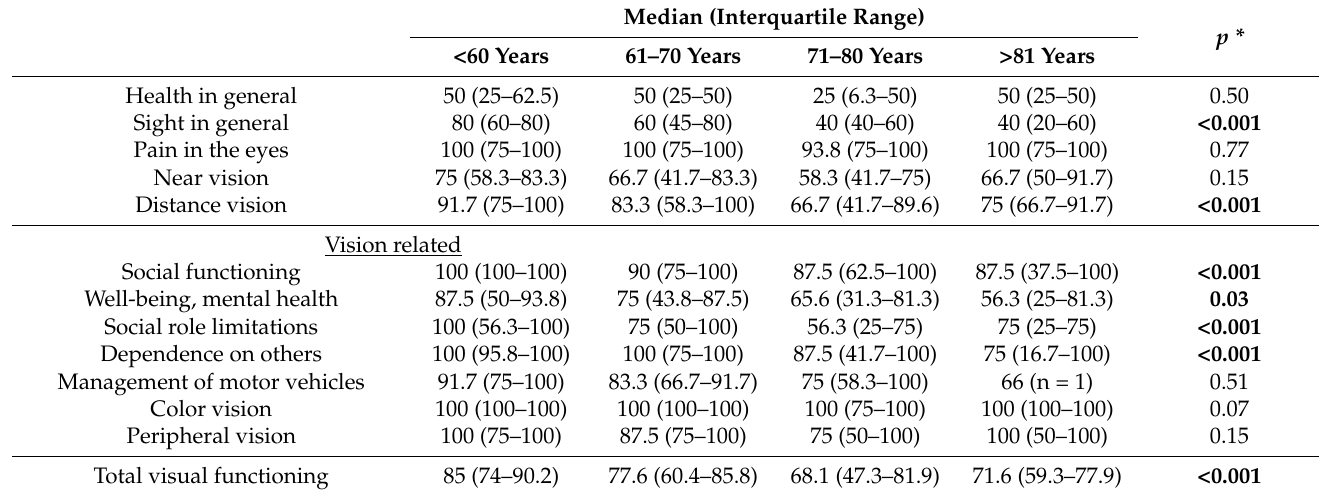
Table 5. Assessments of visual functioning regarding age